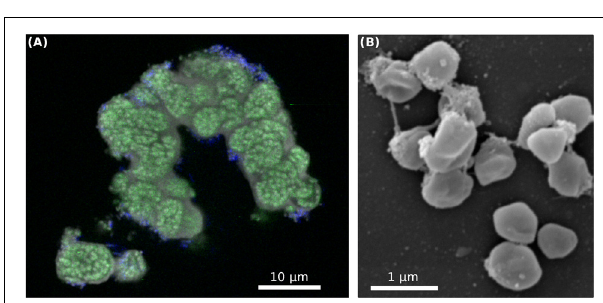
FIGURE 5 | (A) FISH analysis of the enrichment culture illustrating the growth in microcolonies and the high relative abundance of “ Ca. N. islandicus.” “ Ca. N. islandicus” cells appear in green (stained by probe Thaum726 targeting most Thaumarchaeota) and the bacterial contaminants in blue (labeled by probe EUB338). (B) Scanning electron micrograph of spherically shaped “ Ca. Nitrosocaldus islandicus” cells. The cells have a diameter of 0.5–0.7 µ m. “ Ca. N. islandicus” cells were distinguishable from the rod-shaped bacterial contaminants by their smaller size and unique, ‘dented’ spherical